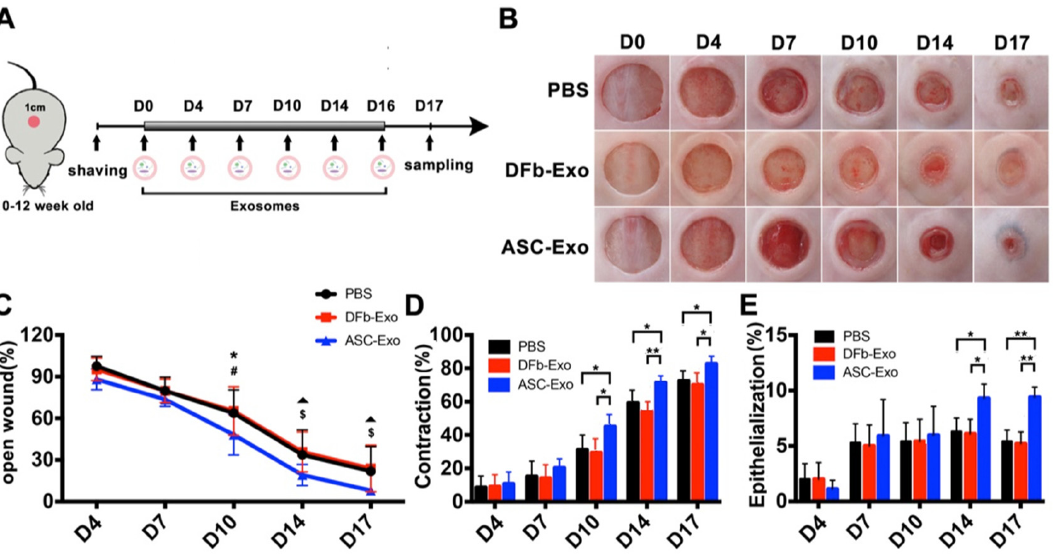
Figure 3. Wound healing kinetics in PBS, dermal fibroblast (DFb) derived exosomes, and adipose stem cell (ASC) derived exosomes treated wounds. ( A ) Scheme illustrating the experimental procedure and treatment in db/db mice; ( B ) representative macroscopic images and quantification of raw surface, re-epithelialization, and contraction. ( n = 8/group); ( C ) time-course changes of raw surface revealed significant differences were found on day 10, 14 and 17 (* compare with DFb or PBS, p < 0.05; # compare with DFb or PBS, p < 0.01); ( D ) enhanced wound contraction was found in ASC-Exo treated wounds on day 10, 14 and 17 (* p < 0.05; ** p < 0.01); ( E ) re-epithelialization was enhanced in ASC-Exo treated wounds when compared with DFb-Exo and PBS group on day 14 and 17 (** p < 0.01). Error bars are mean ± SE. Data were analyzed using independent unpaired two-tailed Student’s t